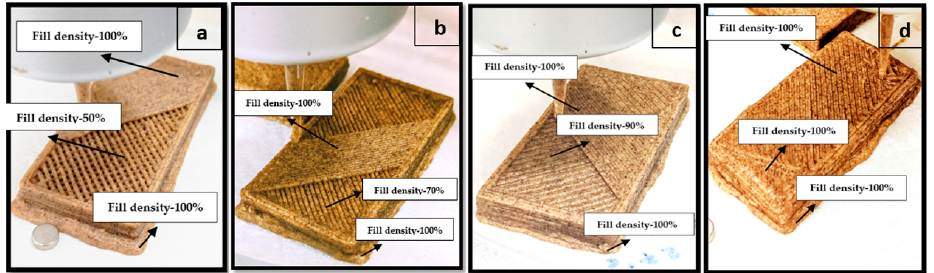
Figure 2. Representative images of 3D-printed dough structure with different fill density values of ( a ) 50%, ( b ) 70%, ( c ) 90%, and ( d ) 100%.